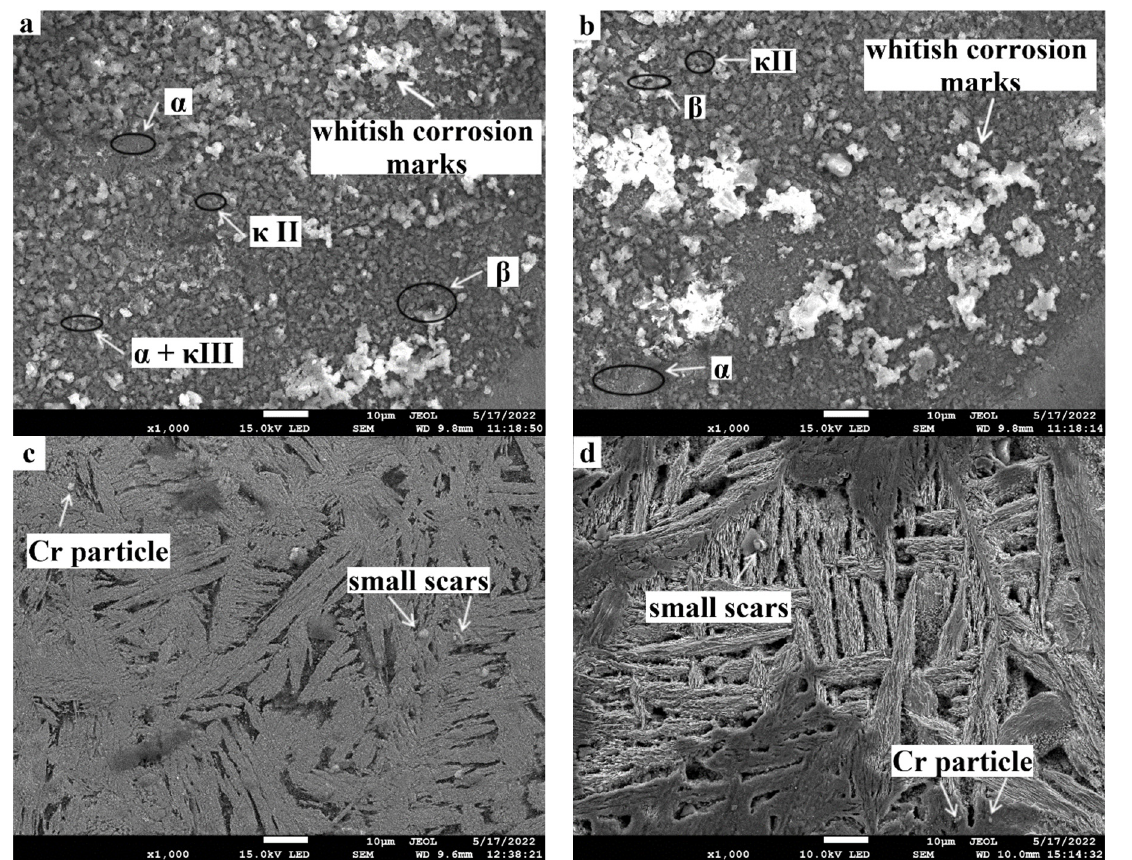
Figure 16. SEM micrographs of ( a ) as-cast NAB specimen surfaces after exposure for 1 day, ( b ) as-cast NAB specimen surfaces after exposure for 16 days, ( c ) FSPed composite after exposure for 1 day, and ( d ) FSPed composite after exposure for 16 days in 3.5% NaCl solution.